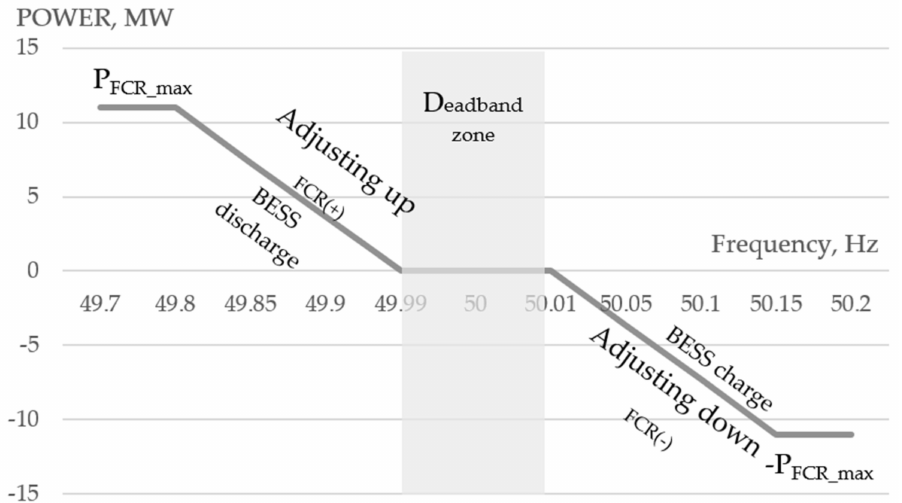
Figure 2. Primary frequency control load-frequency